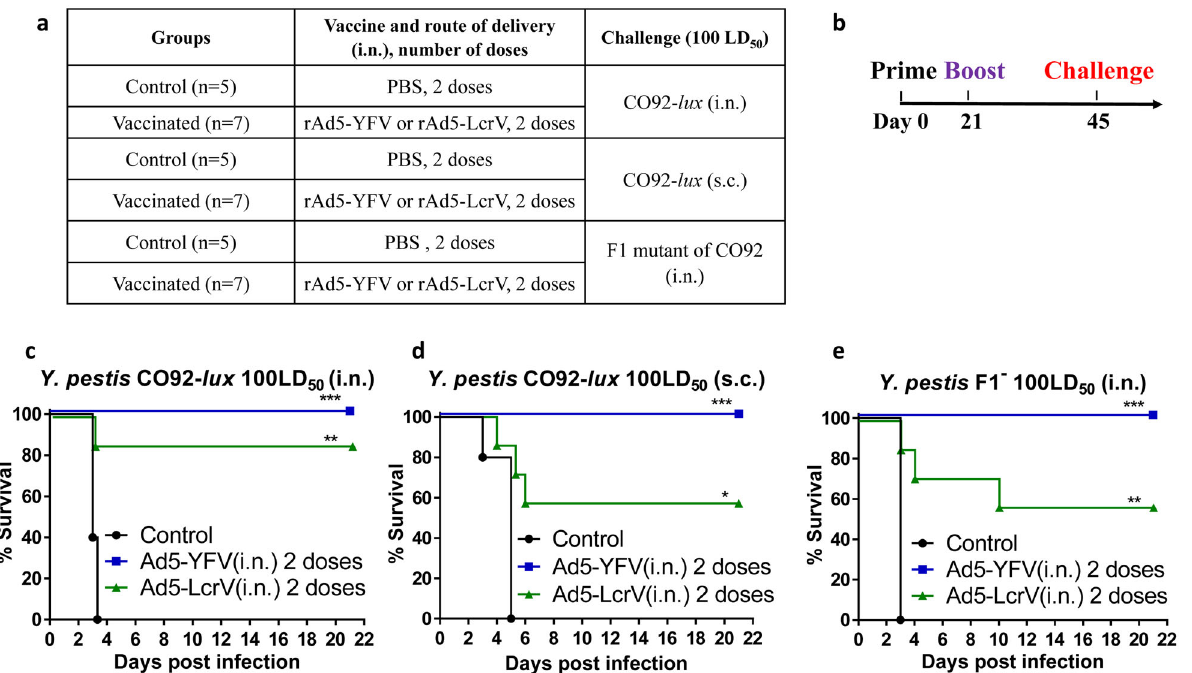
Fig. 2 Animal protection conferred by immunization of mice with rAd5-YFV or rAd5-LcrV vaccines. Mice ( n = 5 – 7/group) were immunized (i.n.) twice 21 days apart with either 1.2 × 10 10 v.p. of rAd5-YFV or rAd5-LcrV vaccines, with mice receiving PBS served as controls ( a ). After 24 days post second immunization, animals were challenged with 100 LD 50 of Y. pestis CO92- lux ( b ) by either i.n. route ( c ) or s.c. route ( d ) or by Y. pestis CO92 F1-negative strain via the i.n. route ( e ). The percent of animal survival was then plotted. P values were calculated using Kaplan – Meier analysis with log-rank (Mantel – Cox) test. Asterisks represent comparison to the control group. * P < 0.05, ** P < 0.01, *** P < 0.001. Two biological replicates were performed, and data